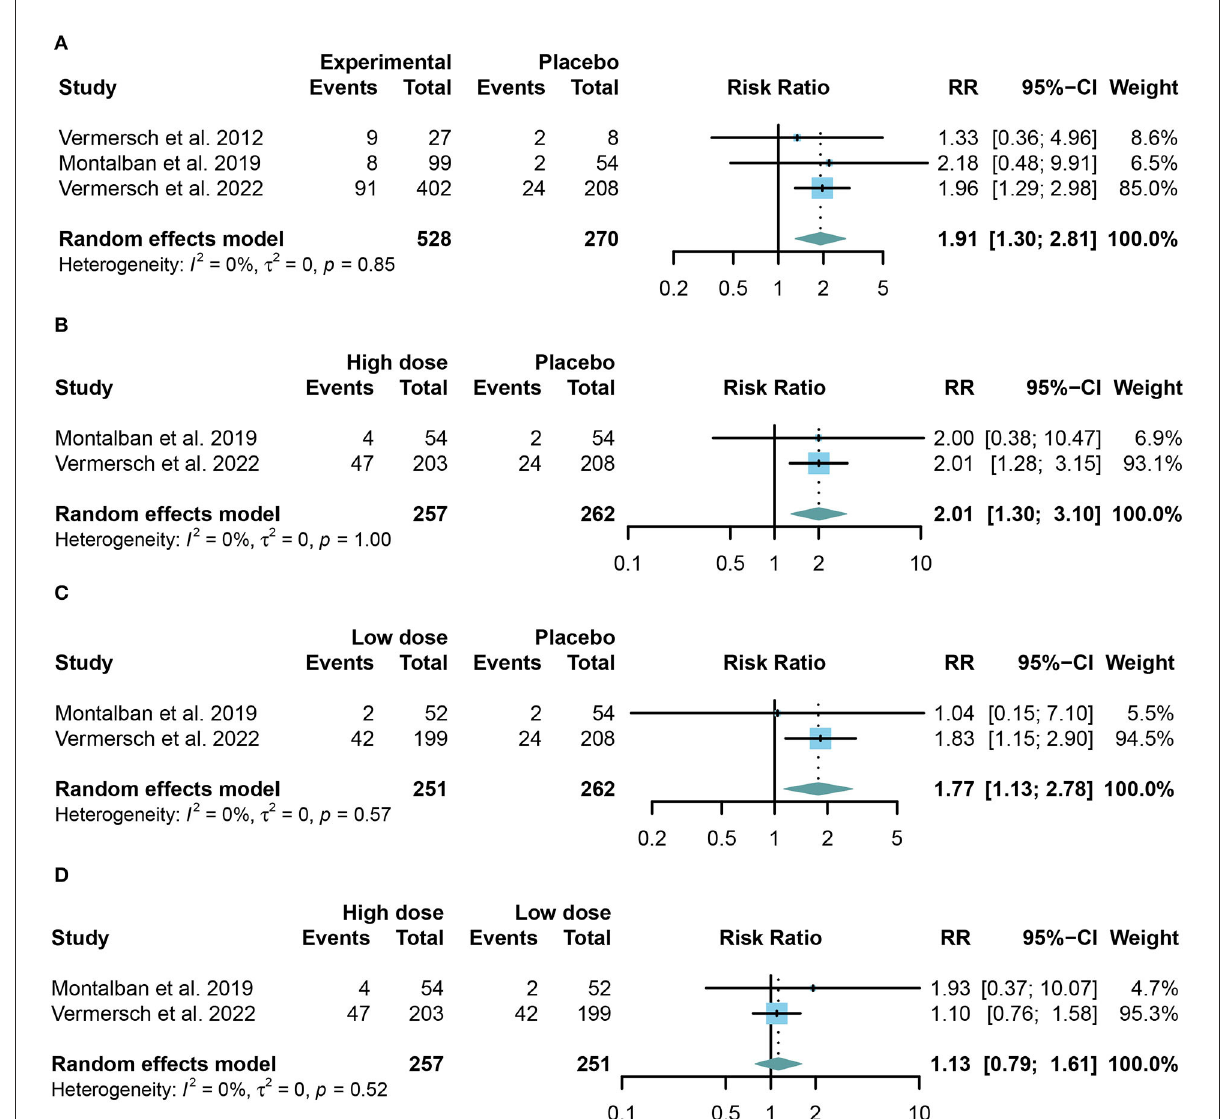
FIGURE5 The pooled risk ratios (RRs) of patients with serious adverse events in different treatment doses compared with the placebo group; the diamond indicates the estimated summary RRs with a 95% confidence interval (CI). (A) Summary of different doses of TKIs compared with the placebo group; (B) high dose of TKIs compared with the placebo group; (C) low dose of TKIs compared with the placebo group; and (D) high dose of TKIs compared with the low dose